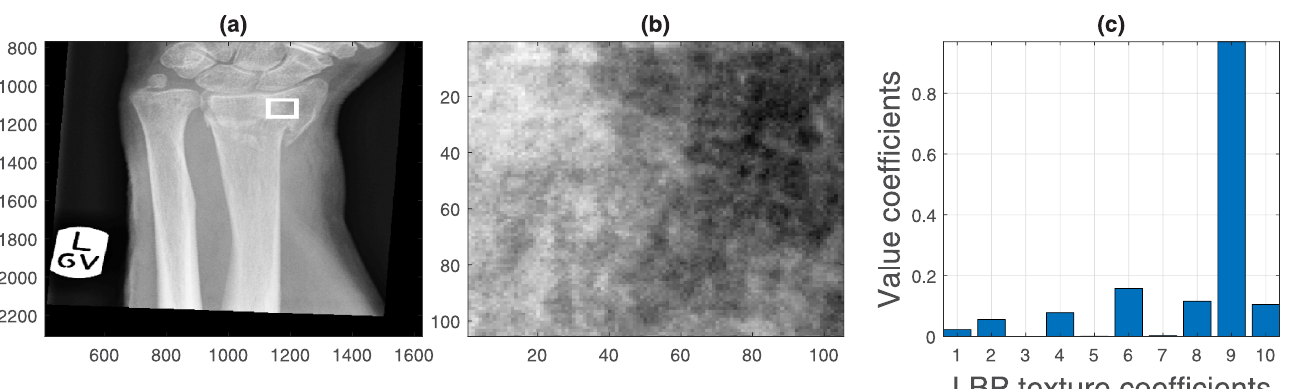
Fig 8. Semi-automatic extraction of texture measurements of a region of interest. (a) To analyse the texture of the radius, a ROI is automatically located by traversing a fixed distance from the radial styloid landmark. (b) Zoom of the region of interest. (c) Texture coefficients generated by Local Binary Pattern analysis.